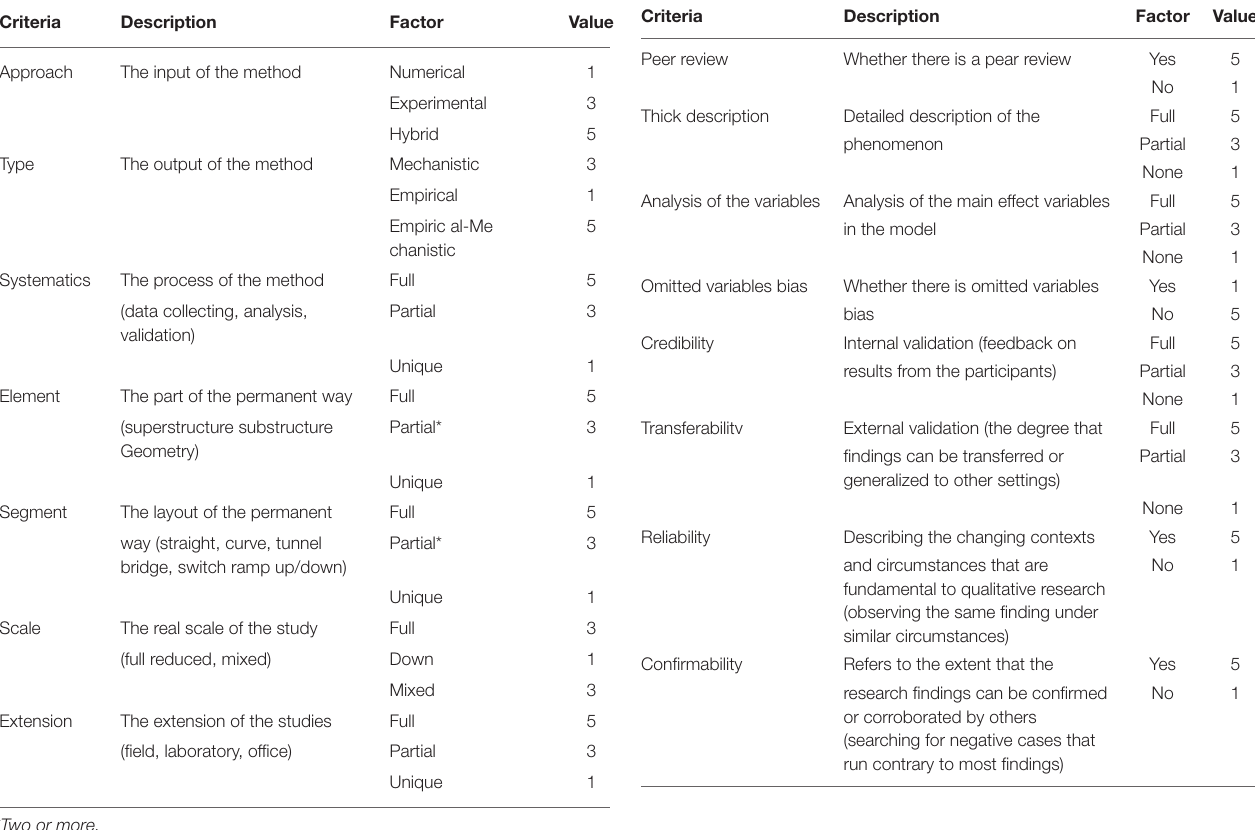
TABLE 3 | Criteria of assessment to the study